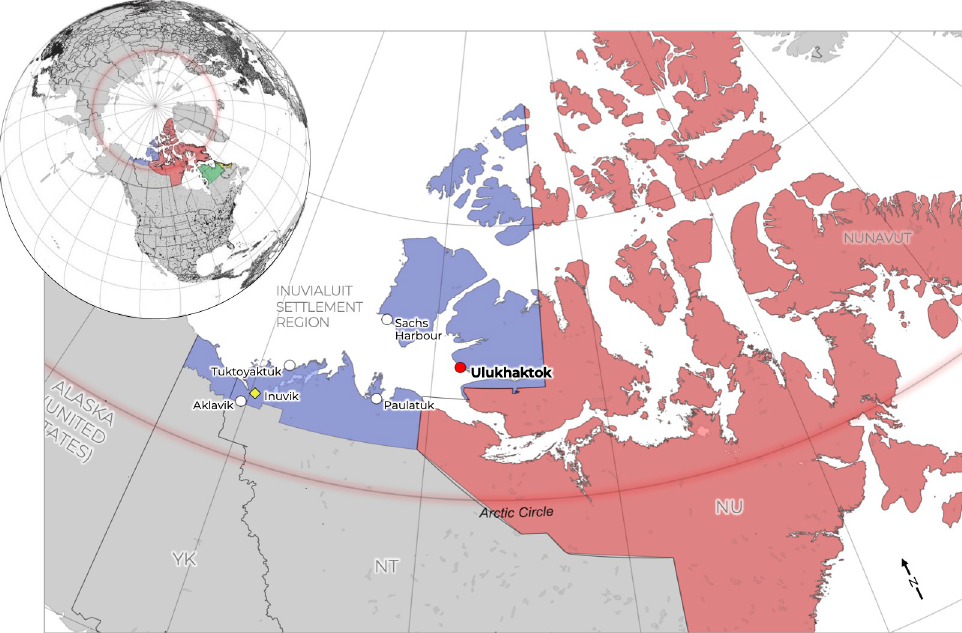
Fig 2. Map of Ulukhaktok and the other five communities within the inuvialuit settlement region of Inuit Nunangat . From Naylor et al. [63].